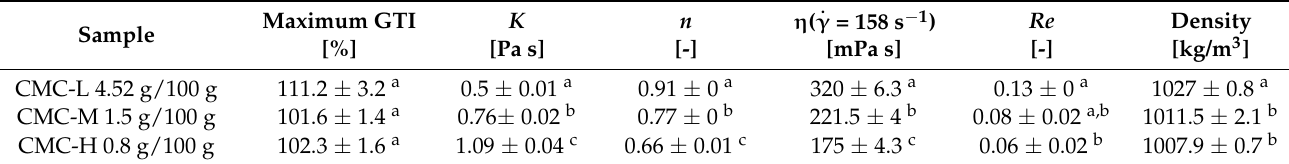
Table 3. Power Law parameters (obtained by Power Law model Equation (10); R 2 ≥ 0.941), viscosities with shearing, Reynolds numbers ( Re ) and densities of the three different CMC solutions at the highest concentration (4.5 g/100 g for CMC-L, 1.5 g/100 g for CMC-M, 0.8 g/100 g for CMC-H); the calculated Re of the blank was 76.53 ± 1.69; viscosities at zero shear see Table